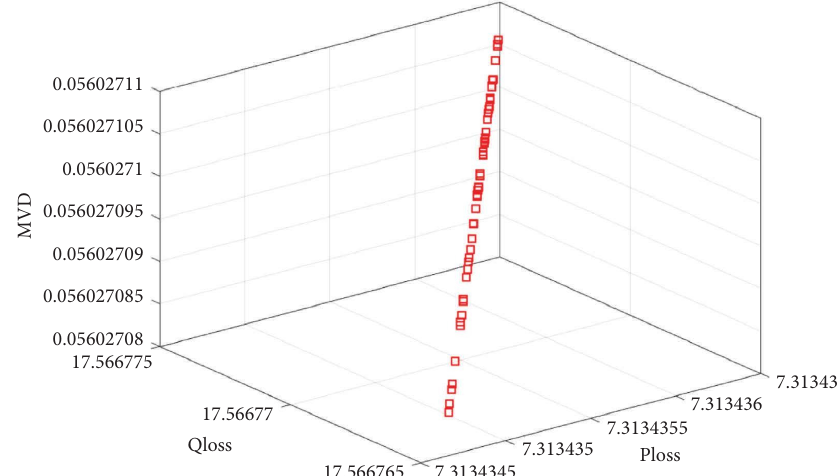
Figure 5: Objective functions in Pareto optimal solutions for the condition of year 2021 without deployment of RE generators.